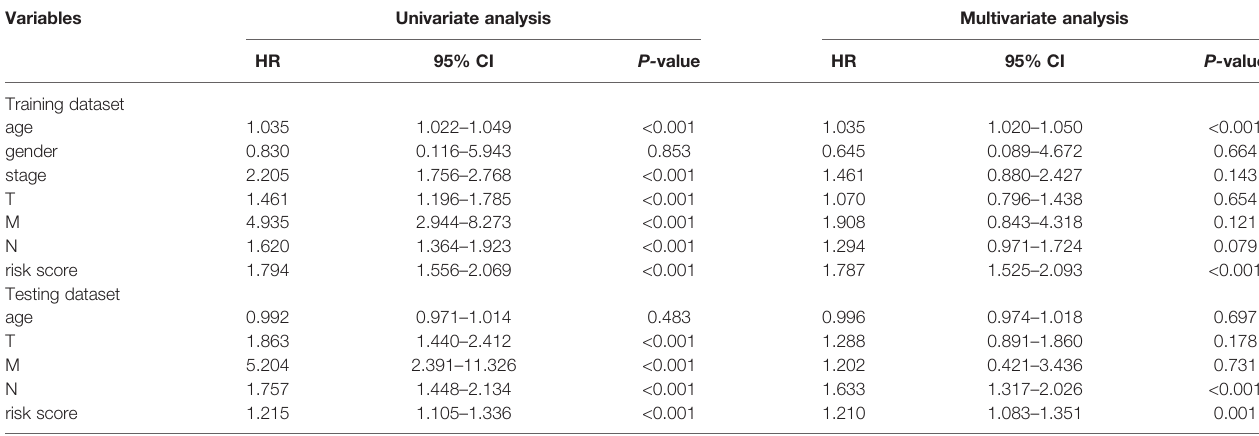
TABLE 4 | Predictive values of related clinical features and risk score in the training dataset and the testing dataset. Variables Univariate analysis Multivariate analysis